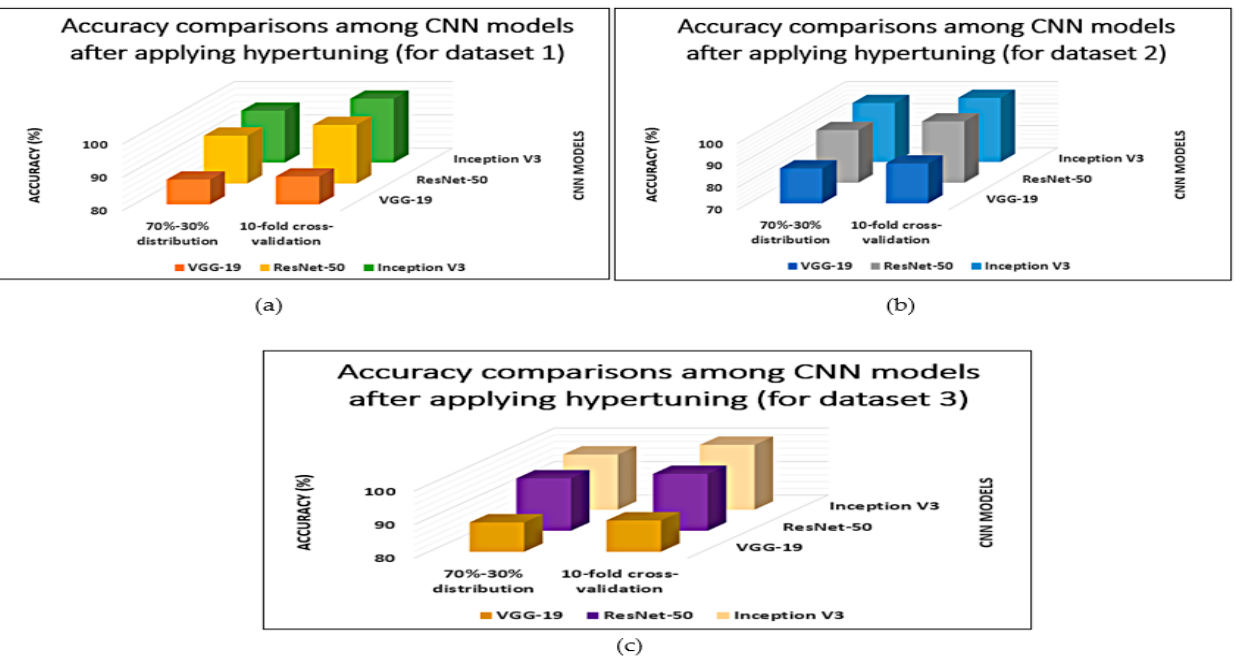
Figure 7. Comparison among VGG-19, ResNet-50, and Inception V3 in terms of accuracy for ( a ) dataset 1, ( b ) dataset 2, and ( c ) dataset 3.